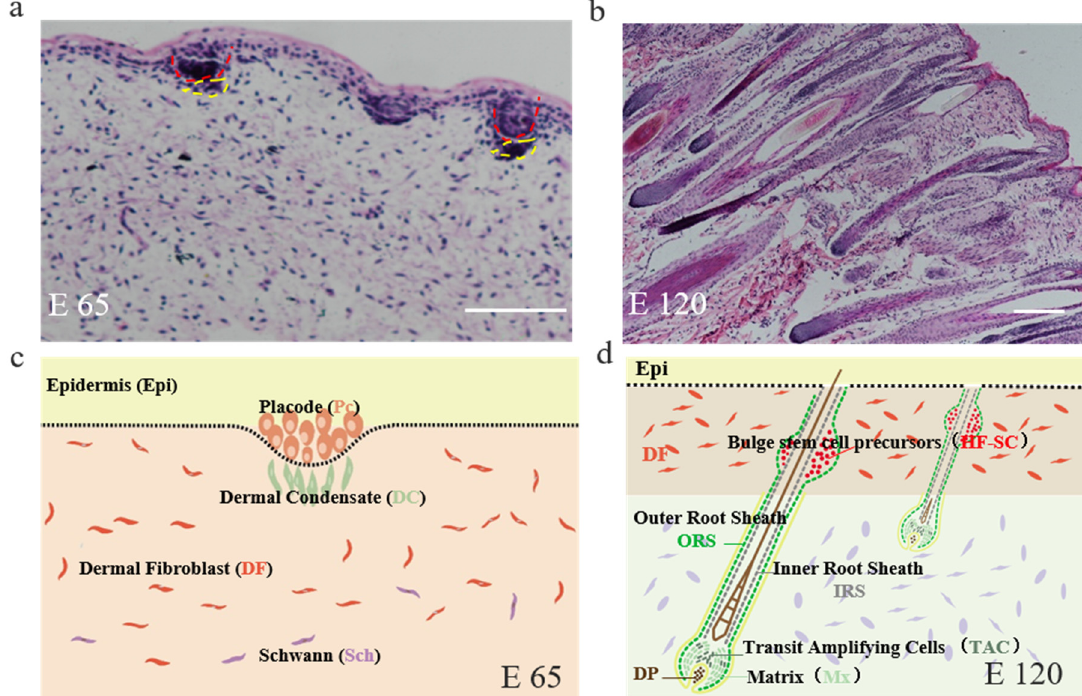
Figure 1. The skin morphology of embryonic day 65 (E 65) and E 120 during hair morphogenesis in Shanbei White Cashmere Goat. ( a , b ) The skin morphology of E 65 and E 120 during hair morphogenesis detected by hematoxylin and eosin staining (scale bars, 50 µ m); ( c , d ) Schematic diagram of the skin morphology in E 65 and E 120 in Shanbei White Cashmere goat. E 65 represents the hair follicle induction stage in which the hair placode (Pc) and dermal condensate (DC) are forming, E 120 represents the hair di ff erentiation stage in which the majority of primary hair follicles mature with a